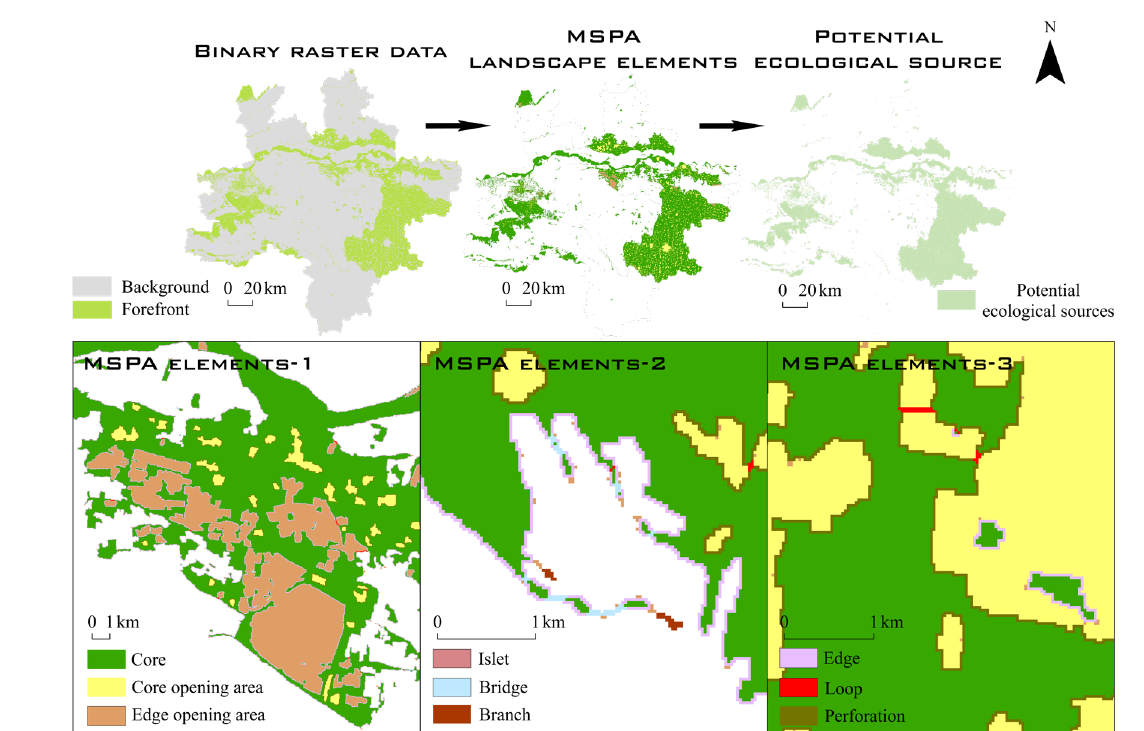
Figure 3. MSPA process and ecological meaning of MSPA types.